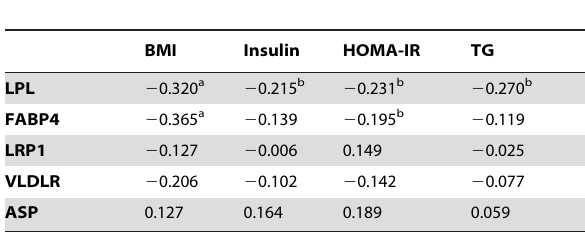
Table 3. Correlations between the visceral adipose tissue mRNA expression levels of the genes studied and the BMI, triglycerides, insulin and HOMA-IR in all study subjects.